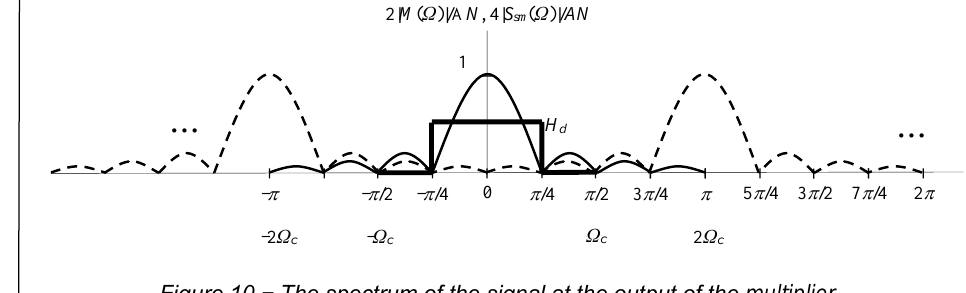
Figure 10 − The spectrum of the signal at the output of the multiplier Рис. 10 – Спектр сигнала на выходе умножителя Слика 10 – Спектар сигнала на излазу